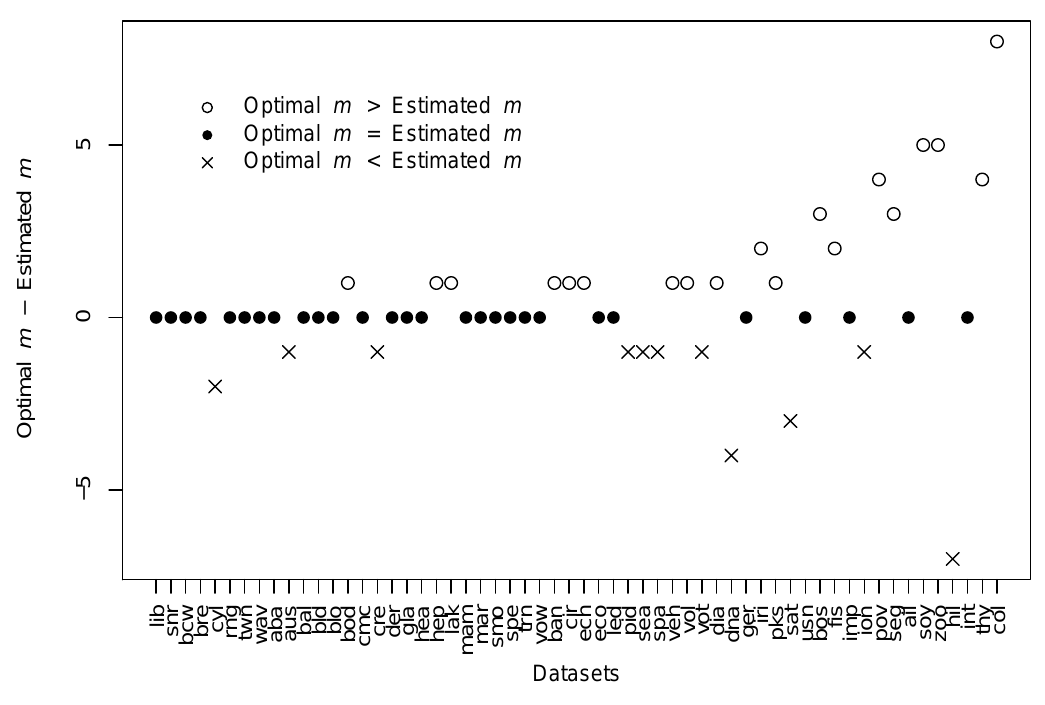
Figure 4. The difference between the optimal m and the estimated m